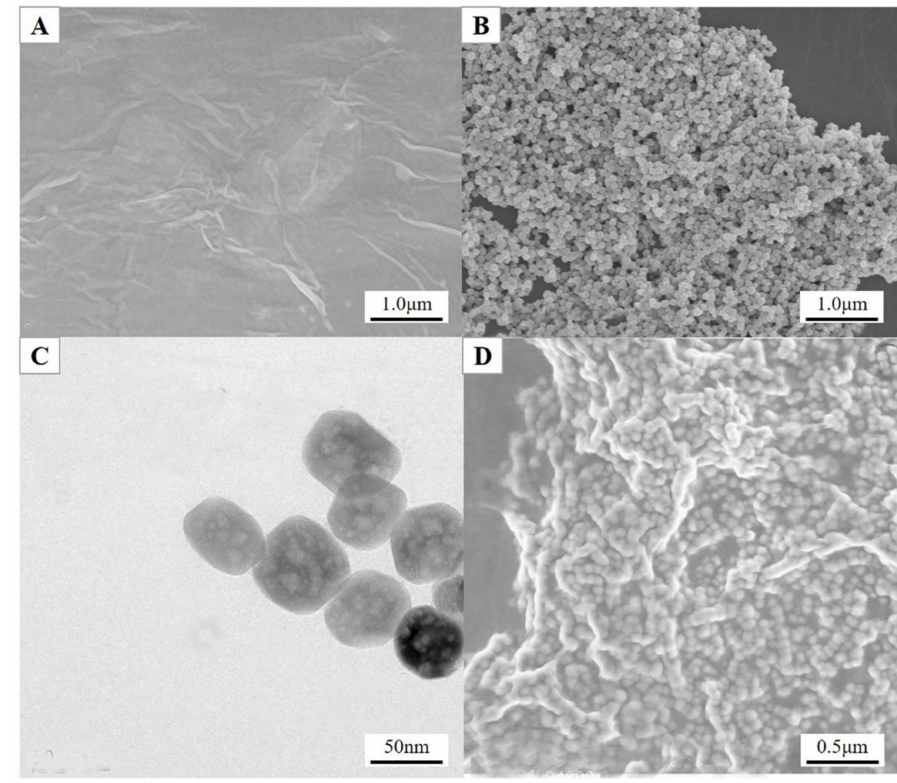
Figure 3. The Scanning Electron Microscopy (SEM) images of reduced graphene oxide (RGO) ( A ), NH 2 –Fe 3 O 4 NPs ( B ) and NH 2 –Fe 3 O 4 /RGO nanocomposites ( D ); The Transmission Electron Microscopy (TEM) image of NH 2 –Fe 3 O 4 NPs ( C